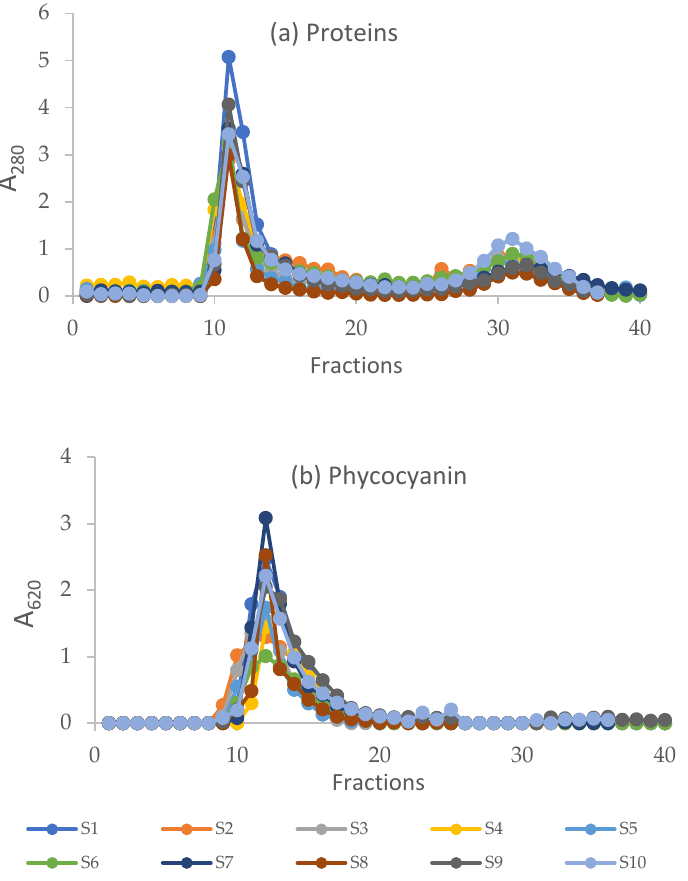
Figure 3. Chromatographic pattern after the size exclusion chromatography of extracts obtained from samples S1–S10. Total proteins were detected at 280 nm ( a ); phycocyanin was detected at 620 nm ( b ).